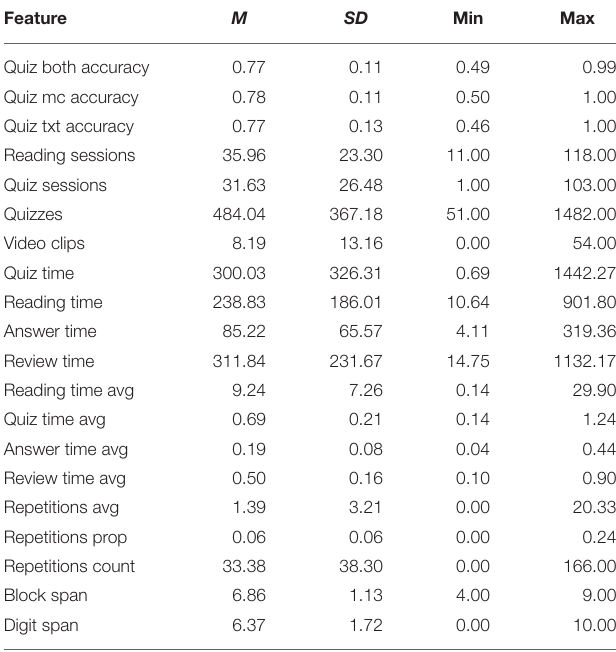
TABLE 2 | Descriptive statistics for the extracted online activity features and the working memory